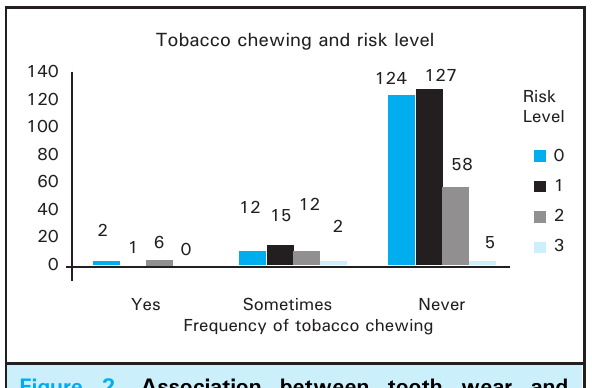
Figure 2. Association between tooth wear and tobacco